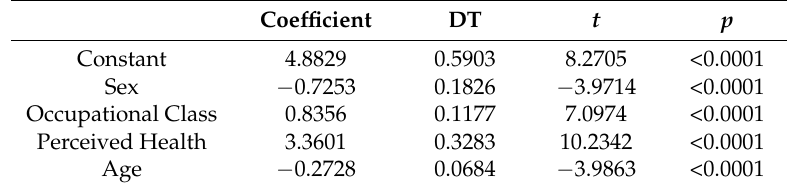
Table 2. Ordinary Least Squares